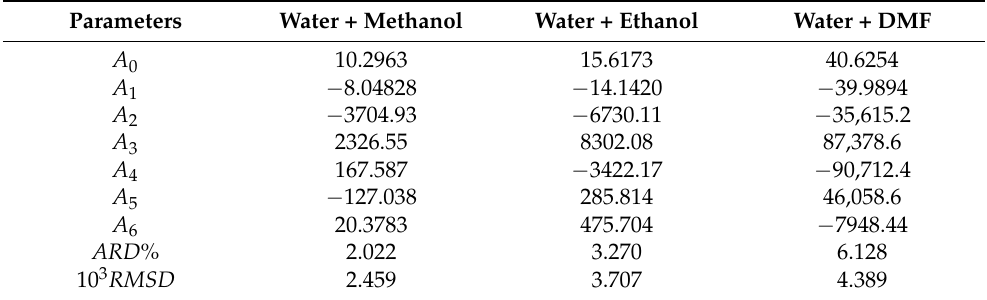
Table 9. Model parameters of Jouyban–Acree equation for 1,5-pentanediamine adipate dihydrate in the investigated binary solvent mixtures a,b,c .